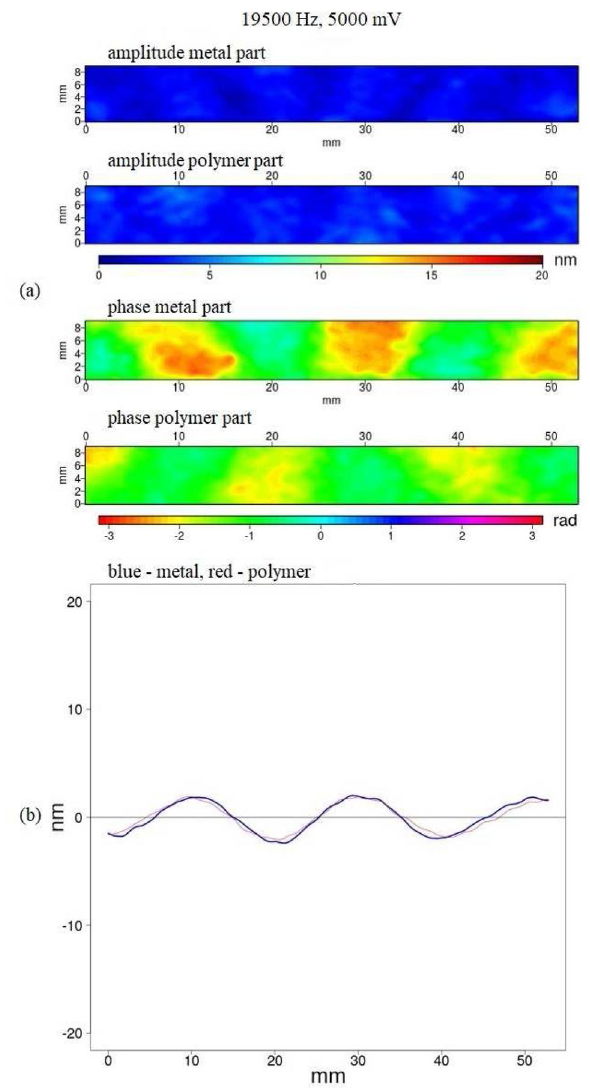
Figure 9. ( a ) Amplitude and phase pattern of a PLA_Al laminate sample without a defect. ( b ) The amplitude data from ( a ), averaged along the y-direction; blue—aluminium, red—polymer. The colour bars indicate the amplitude in nm, the phase in rad. The size of the visible part of the sample is 54 × 9.5 mm located around 28